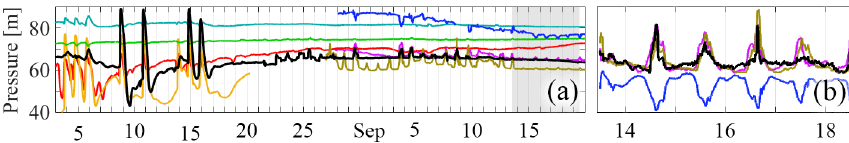
Figure 13. (a) Water pressure in a hydraulic cluster observed in August 2015 that we then identified as a mechanical in mid-September 2015. (b) Diurnal residual for the period between 14 and 18 September 2015, using the same colour coding as panel (a) . It can be seen how the sensor in black transitioned from displaying a large-amplitude hydraulic signal to small-amplitude one, characteristic of mechanical